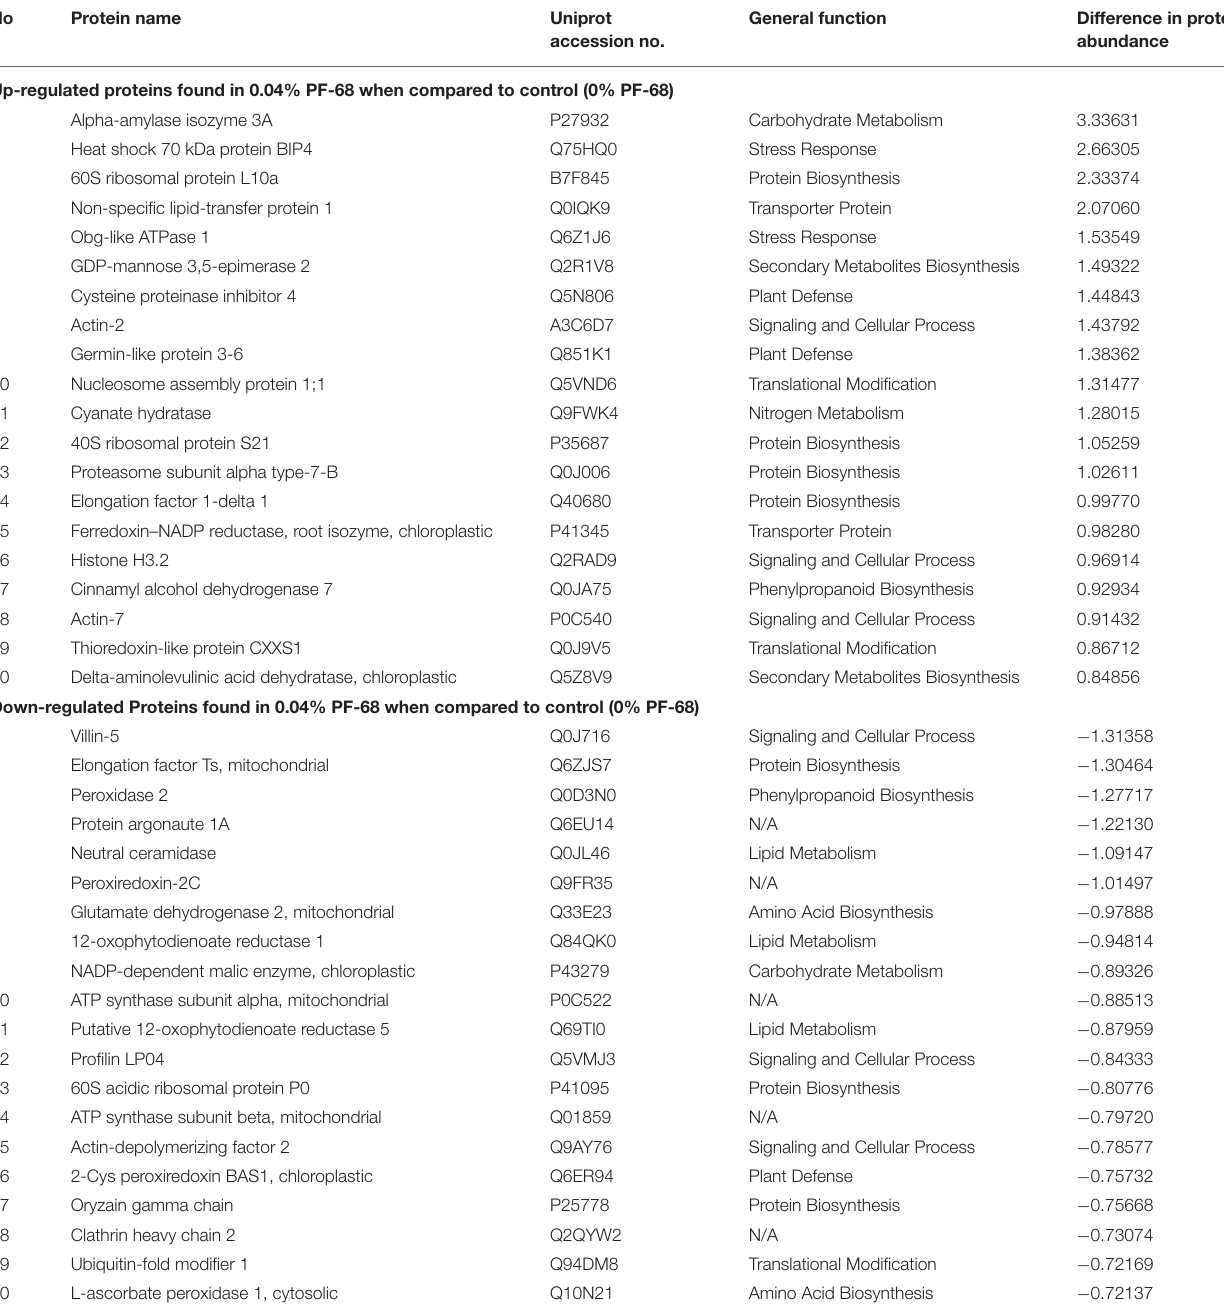
TABLE 2 | Top 20 proteins showing significant abundance difference (together with their accession numbers) between control and optimum PF-68 concentrations. No Protein name Uniprot General function Difference in protein accession no.